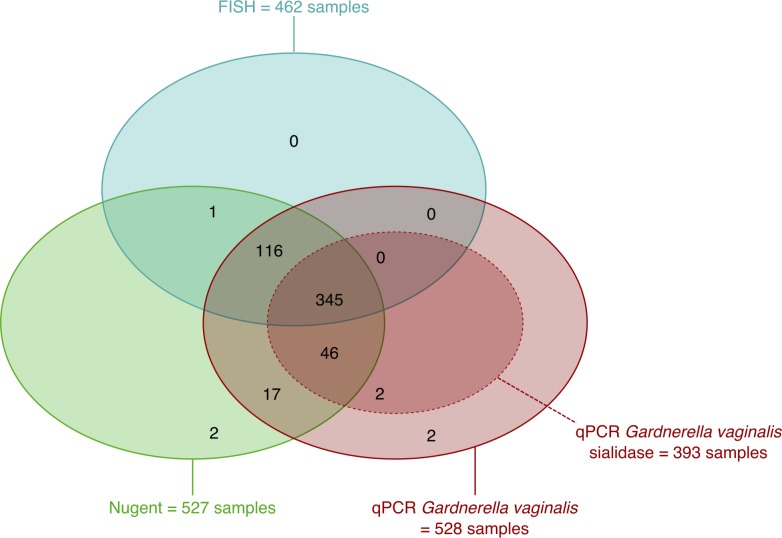
Overview of different subsets of samples analysed with fluorescence in situ hybridisation (n = 462), Nugent score (n = 527), G. vaginalis quantitative polymerase chain reaction (n = 528) and G. vaginalis sialidase quantitative polymerase chain reaction (n = 393).